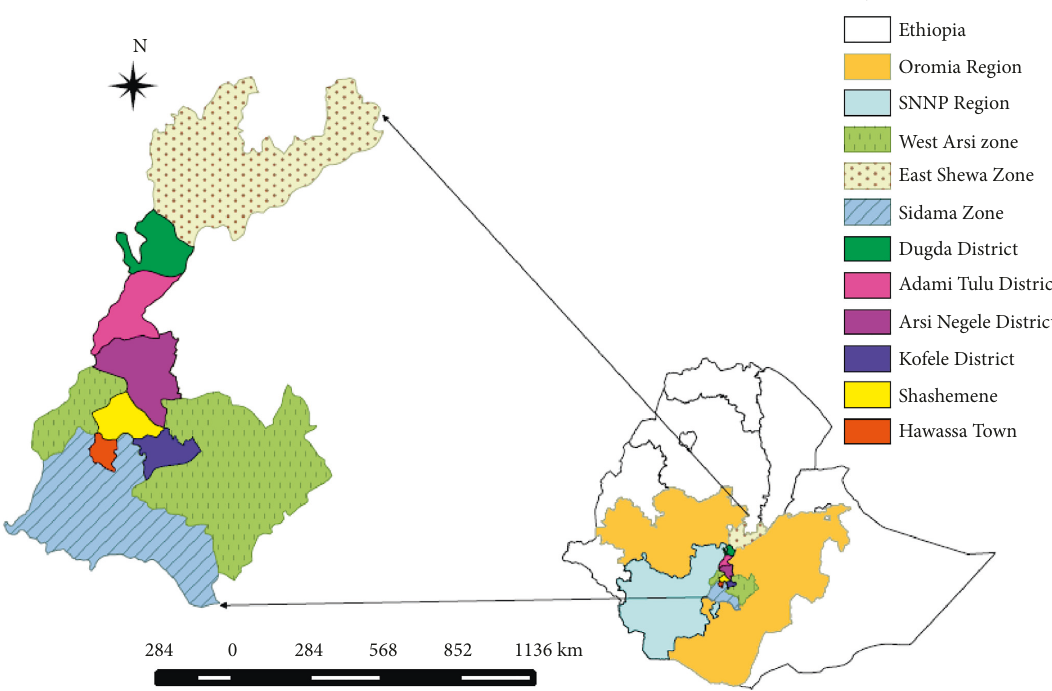
Figure 1: Map of study